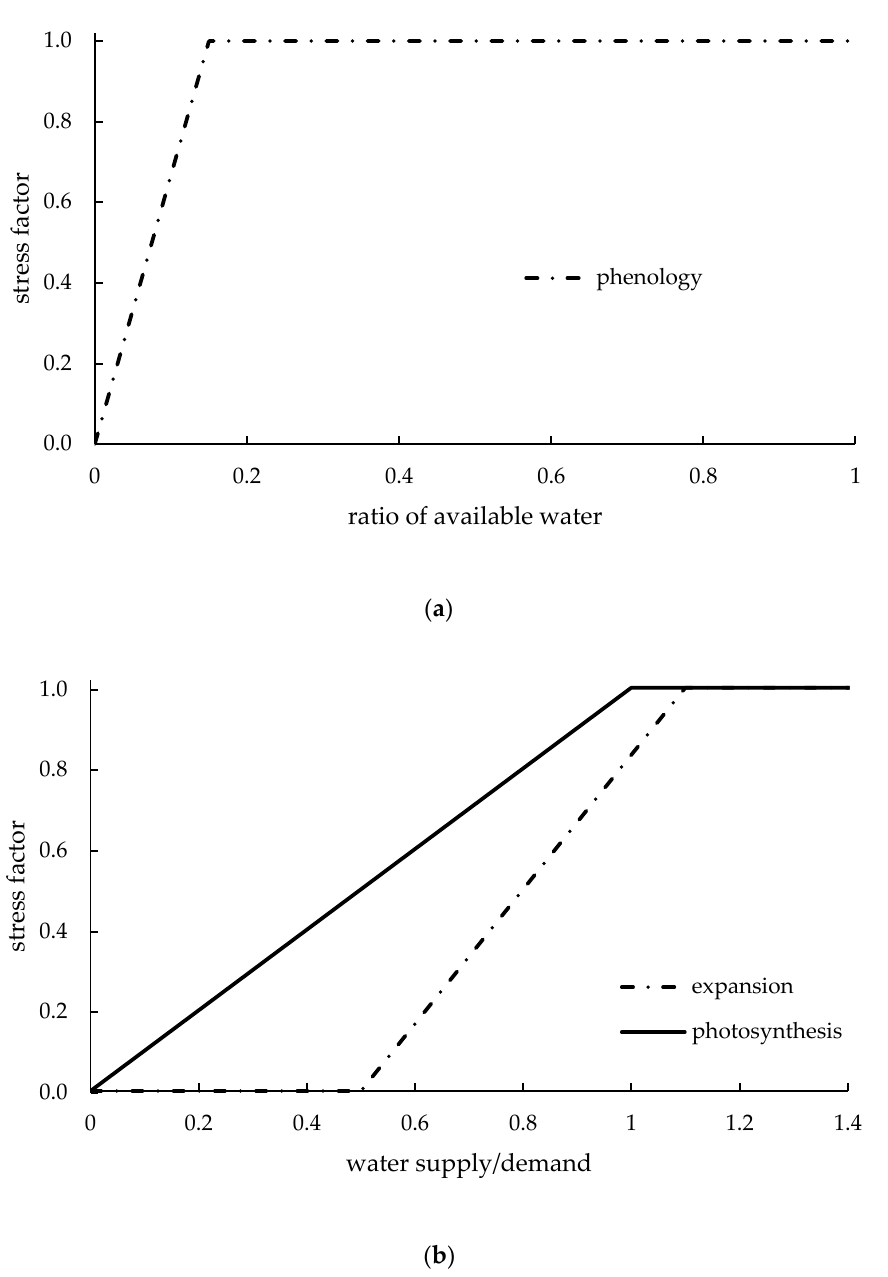
Figure 7. WS of the plant module in APSIM (redrawn from the model documentation available with the download of APSIM 7.1). The approaches can be soil moisture-related or transpiration deficit-related, depending on the process affected. ( a ) WS coefficient (0–1 range) affecting phenology. The stress is calculated on the ratio of available water (ratio of TAW), similarly to AQUACROP. ( b ) WS coefficients (0–1 range) affecting leaf expansion and photosynthesis. These stresses are based on the ratio of water supply (RWUp) to demand (Tp), similarly to